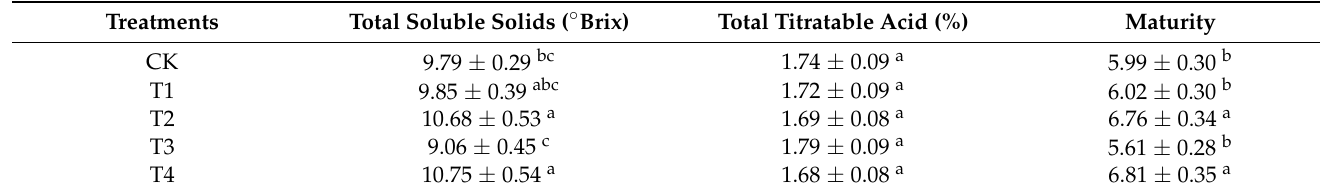
Table 3. The total soluble solids content, titratable acid content and maturity of cherry tomato fruit grown with different dynamic concentrations of nutrient solution. The average content of total soluble solids and titratable acid as well as fruit maturity from five harvests conducted on 24 Nov., 7 Dec., 20 Dec., 31 Dec. 2021 and 19 Jan. 2022. The mean and SD were calculated from three plants in each different growth trough. Lowercase letters in the upper right corner of the SD values represent significant differences ( p ≤